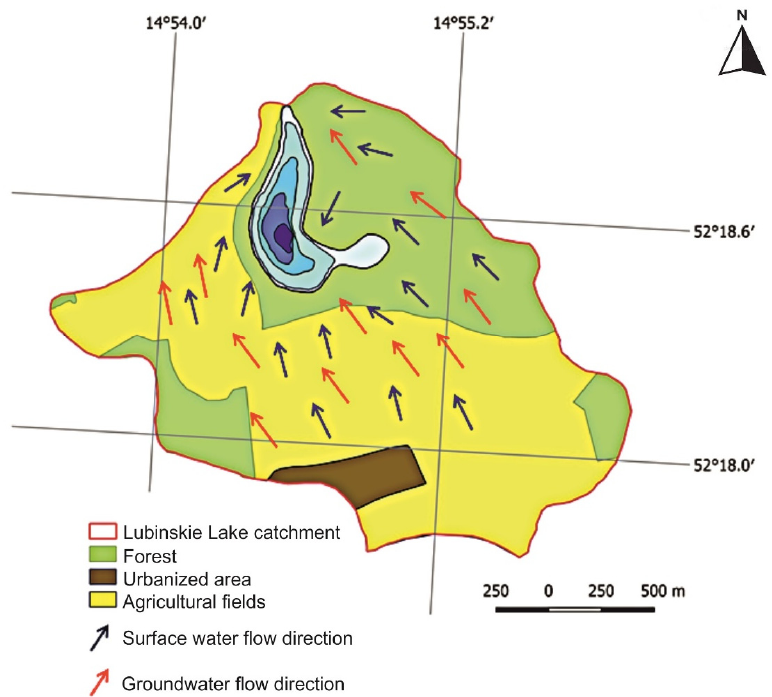
Figure 3. Structure of land use in the catchment of Lubi ń skie Lake based on the orthophotomap.